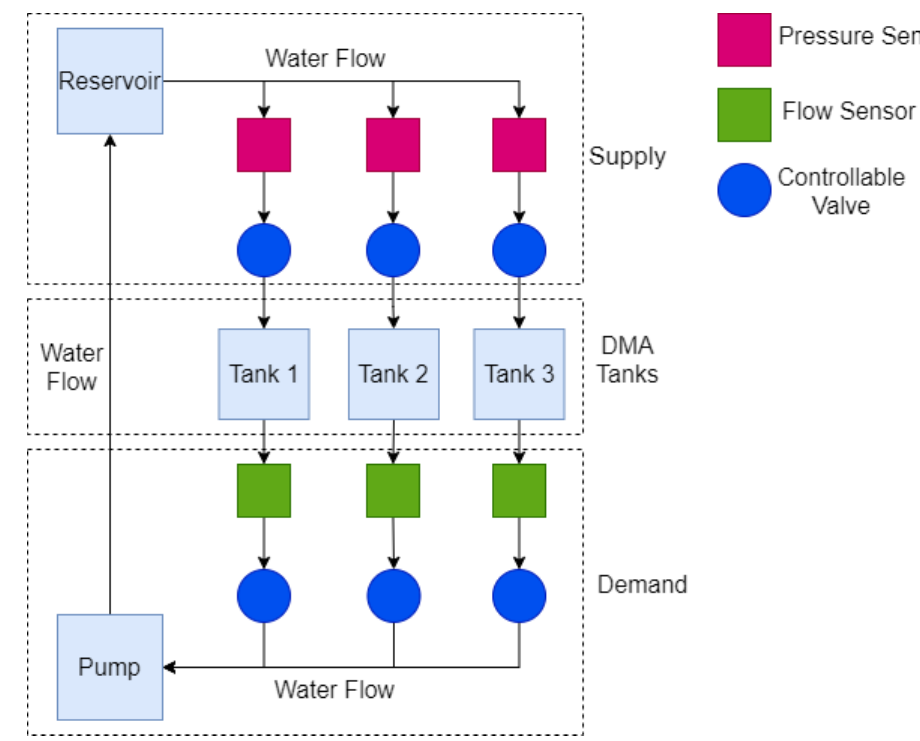
Figure 63. The schematic drawing of the WaterBox testbed. Adapted from